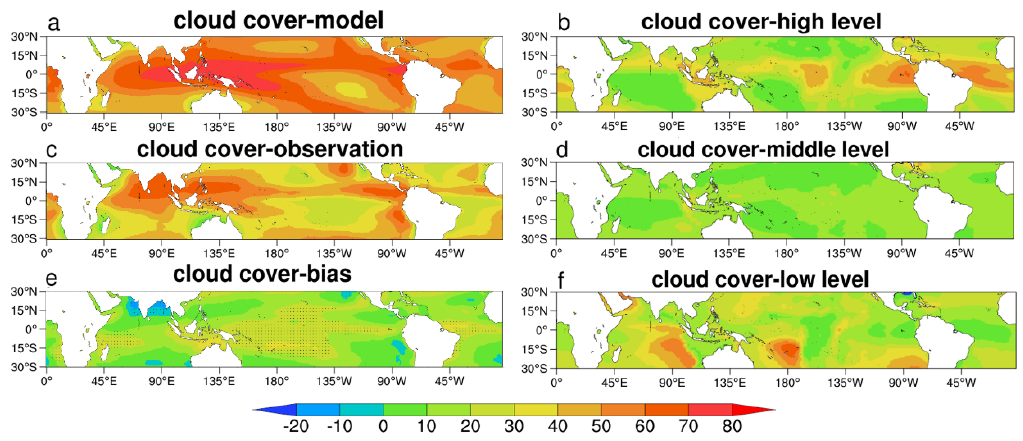
Figure 9. (left) Total cloud cover (%) from the model ensemble ( a ), observation ( c ) and bias ( e ) (model ensemble minus observation). (right) High- ( b ), mid- ( d ), and low-level ( f ) clouds (%) from the ISCCP data. Dotted areas indicate where the bias is statistically significant at the 95% level.